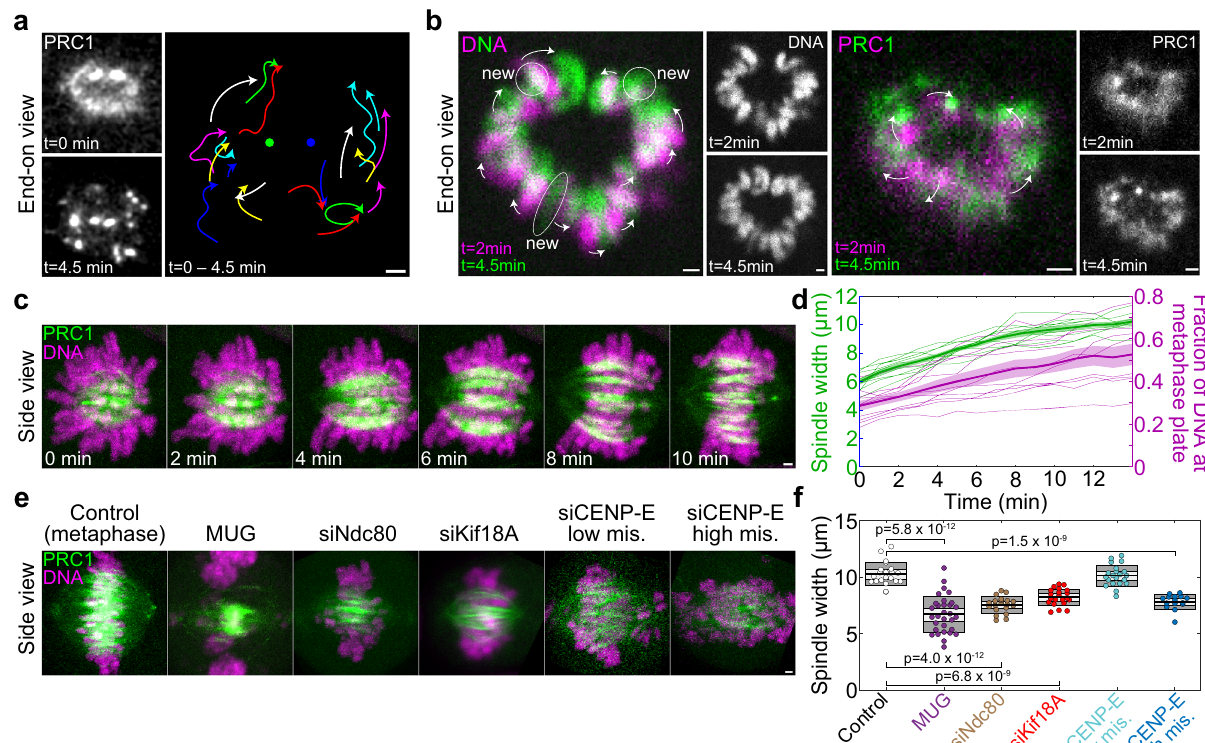
Fig. 4 | Chromosomes separate microtubule bundles and increase spindle width. a Left, Vertical prometaphase spindle midplane in a HeLa-Kyoto cell expressing PRC1-GFP(white),before ( t =0)and after antiparallelbundle formation ( t =4.5min). Right, trajectories of all bundles from time 0 (free end of each curve) until 4.5min (arrowheads), where the points between the end points were smoothed for better visibility and raw data are shown in Supplementary Movie 5. Two large bundles visible at the top at time 0 are fi xed in space (central points). Time interval between images is 2.7s. Similar results were obtained in 8 indepen- dent experiments. b Midplane of a vertical prometaphase spindle, showing DNA stainedwithSiR-DNA(leftblock)orPRC1-GFP(rightblock),asindicated,inaHeLa- Kyoto cell expressing PRC1-GFP, at t =2min (magenta) and t =4.5min (green). Individual images are shown in white at the right of the merged images. Encircled areasmarked “ new ” denotethechromosomesthatarrived tothespindlemidplane between t =2min and t =4.5min, arrows denote the movement of DNA (left) or